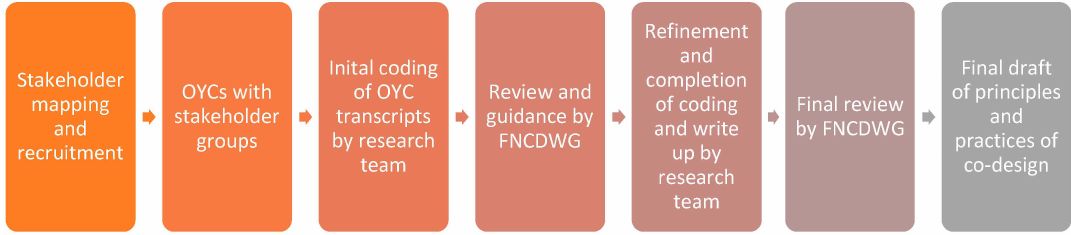
Figure 1. Flowchart of the development process.